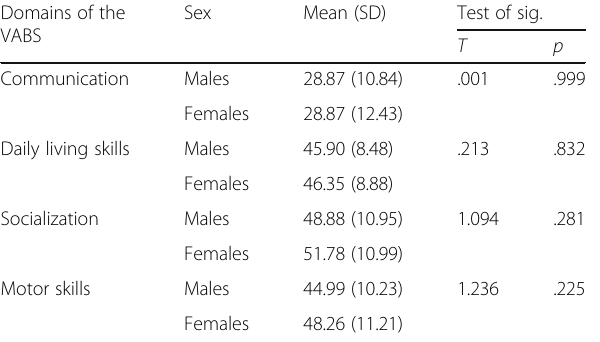
Table 1 Sex difference regarding adaptive behaviour Domains of the VABS